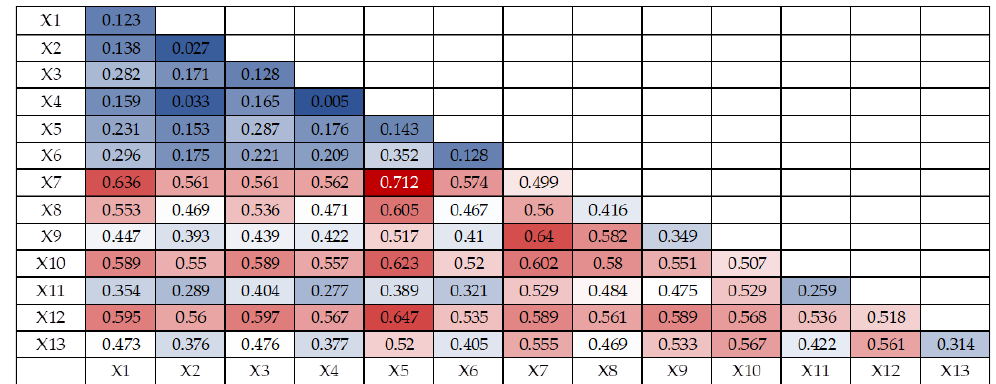
Figure 7. Ecological Vulnerability Interaction Detector Results in Shenyang in 2015.